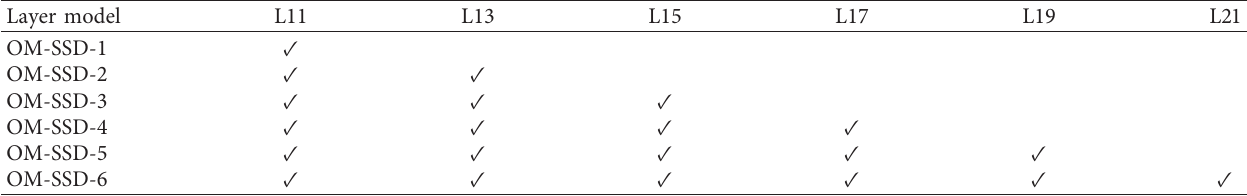
Figure 6: Conveyor belt images captured at different DDs and heights. (a) DD � +5%, shooting height from left to right: 2.4m, 2.6m, 2.8m, and 3.0 m. (b) DD � 0%, shooting height from left to right: 2.4m, 2.6m, 2.8m, and 3.0 m. (c) DD �− 5%, shooting height from left to right: 2.4m, 2.6 m, 2.8m, and 3.0m. Table 2: Configuration of OM-SSD with different prediction source